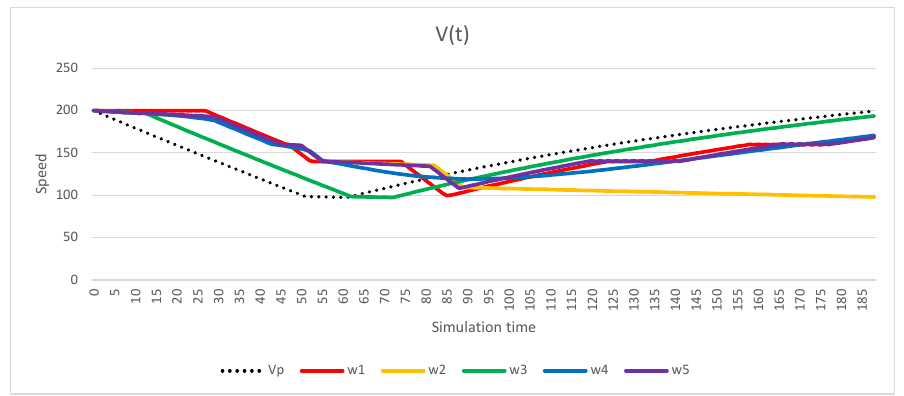
Figure 16. Velocity change V ( t ) in simulation by context 2 for distance D 0 = 2000 m.